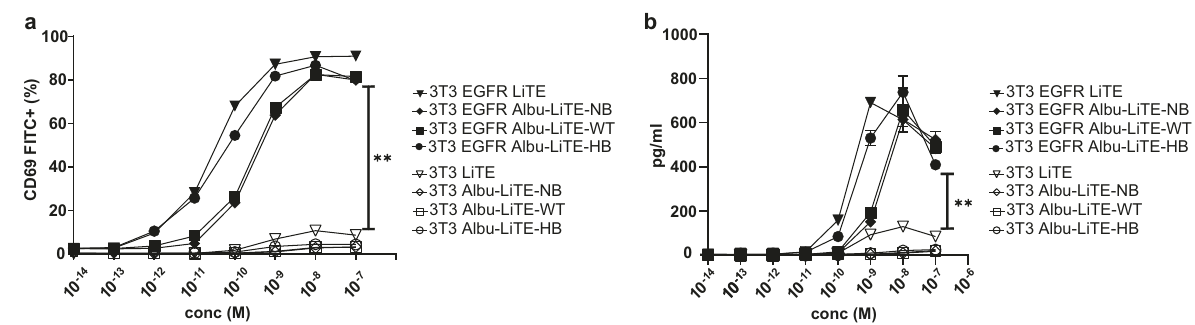
Fig. 5 T-cell activation by LiTE and Albu-LiTE constructs. a An increasing dose of the tested construct (LiTE; triangle, Albu-LiTE-NB; diamond, Albu-LiTE- WT; square, Albu-LiTE-HB; circle) was added to Jurkat T-cells co-cultured with either 3T3 (open symbols) or 3T3 EGFR cells (closed symbols). The expression of CD69 on the T-cells was evaluated by fl ow cytometry. b Media harvested from the co-cultures were tested for IL-2 secretion in ELISA. Signi fi cant differences were observed for T-cell activation on 3T3 or 3T3 EGFR cells in both experiments. Statistical analysis was made by GraphPad prism v.8 using two-way ANOVA with multiple comparisons and Tukey ’ s post hoc correction, ** p < 0.01. Error bars represent